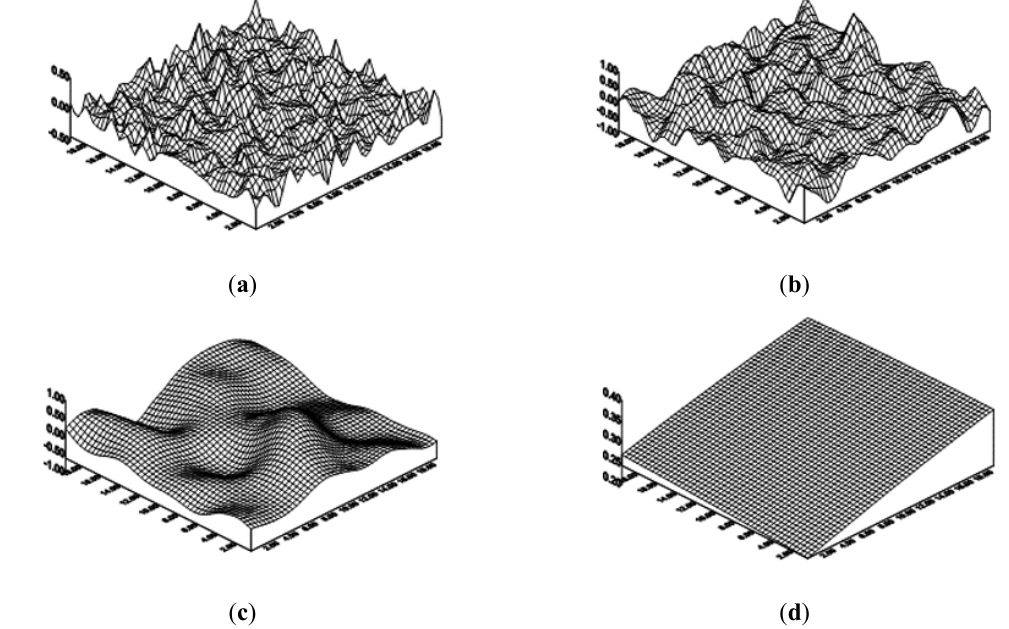
Figure 4. Stochastic field (2D-1V): ( a ) d = 1.0; ( b ) d = 5.0; ( c ) d = 10.0; ( d ) d = 50.0.